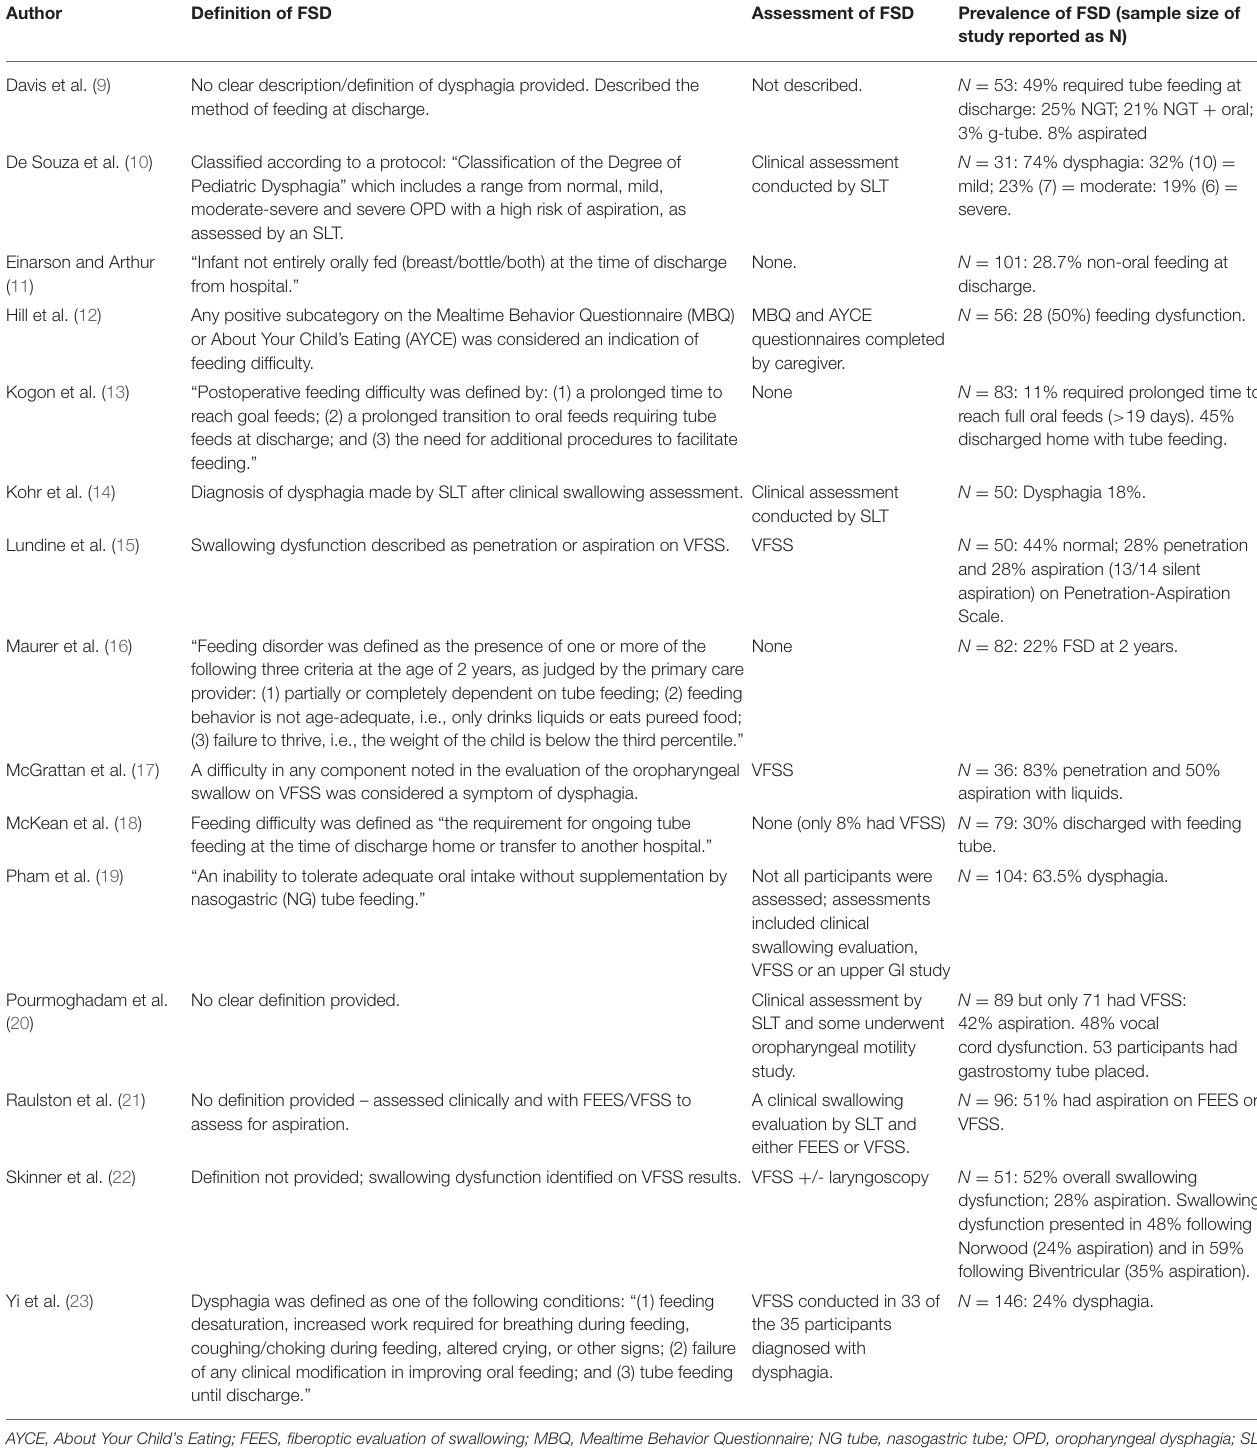
TABLE 2 | Feeding and swallowing difficulties in congenital heart disease: definition, assessment and